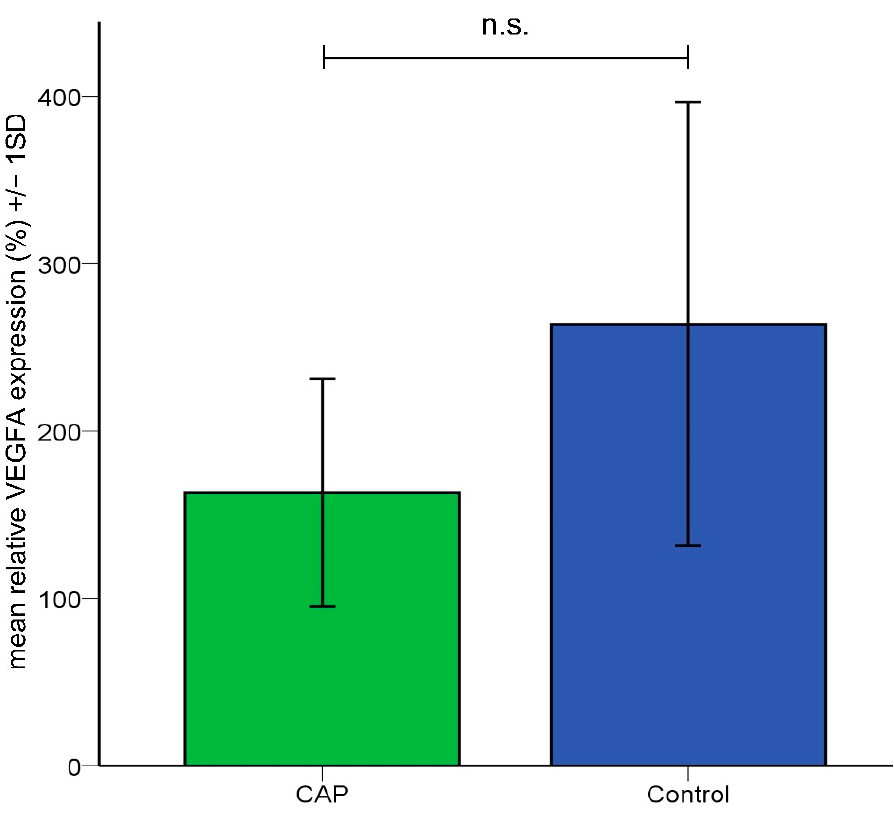
Figure 4. Mean relative VEGFA gene expression in the CAM tissue. Lower relative expression of VEGFA in CAM tissue treated with CAP was not significant compared to sham-treated tissue.